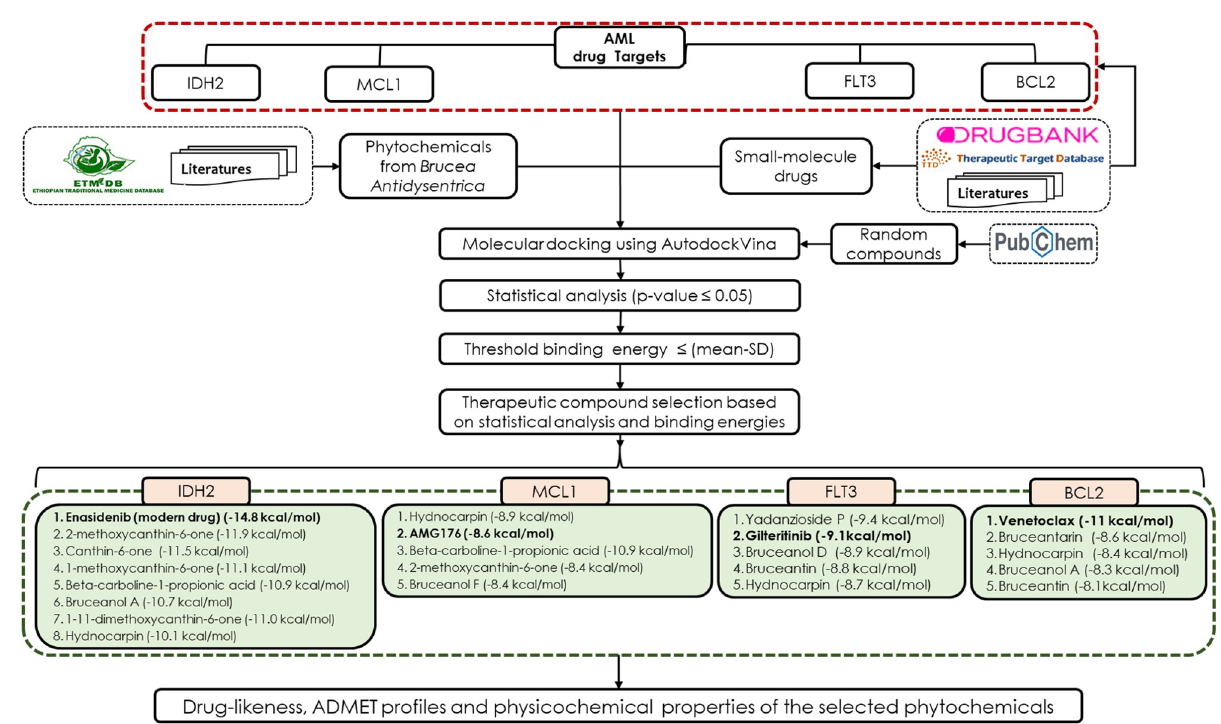
Fig 1. Schematic representation of the various processes used in the study. Briefly, AML targets and modern drugs (small molecule drugs) were obtained from drug bank, therapeutic target database (TTD) and/or literatures sources. B . antidysentrica phytochemicals were compiled from Ethiopian traditional medicine database (ETM-DB) and/or literatures. Then, the modern drugs, phytochemicals and random compounds (obtained from PubChem) were docked with AML targets. Binding energies of small molecule drugs and phytochemicals were evaluated against that of random compounds with statistical test. Finally, the candidate therapeutic phytochemicals were selected based on the statistical analysis and cutoff binding energies. In addition, the candidate compounds were further evaluated for drug-likeness, physicochemical and ADMET